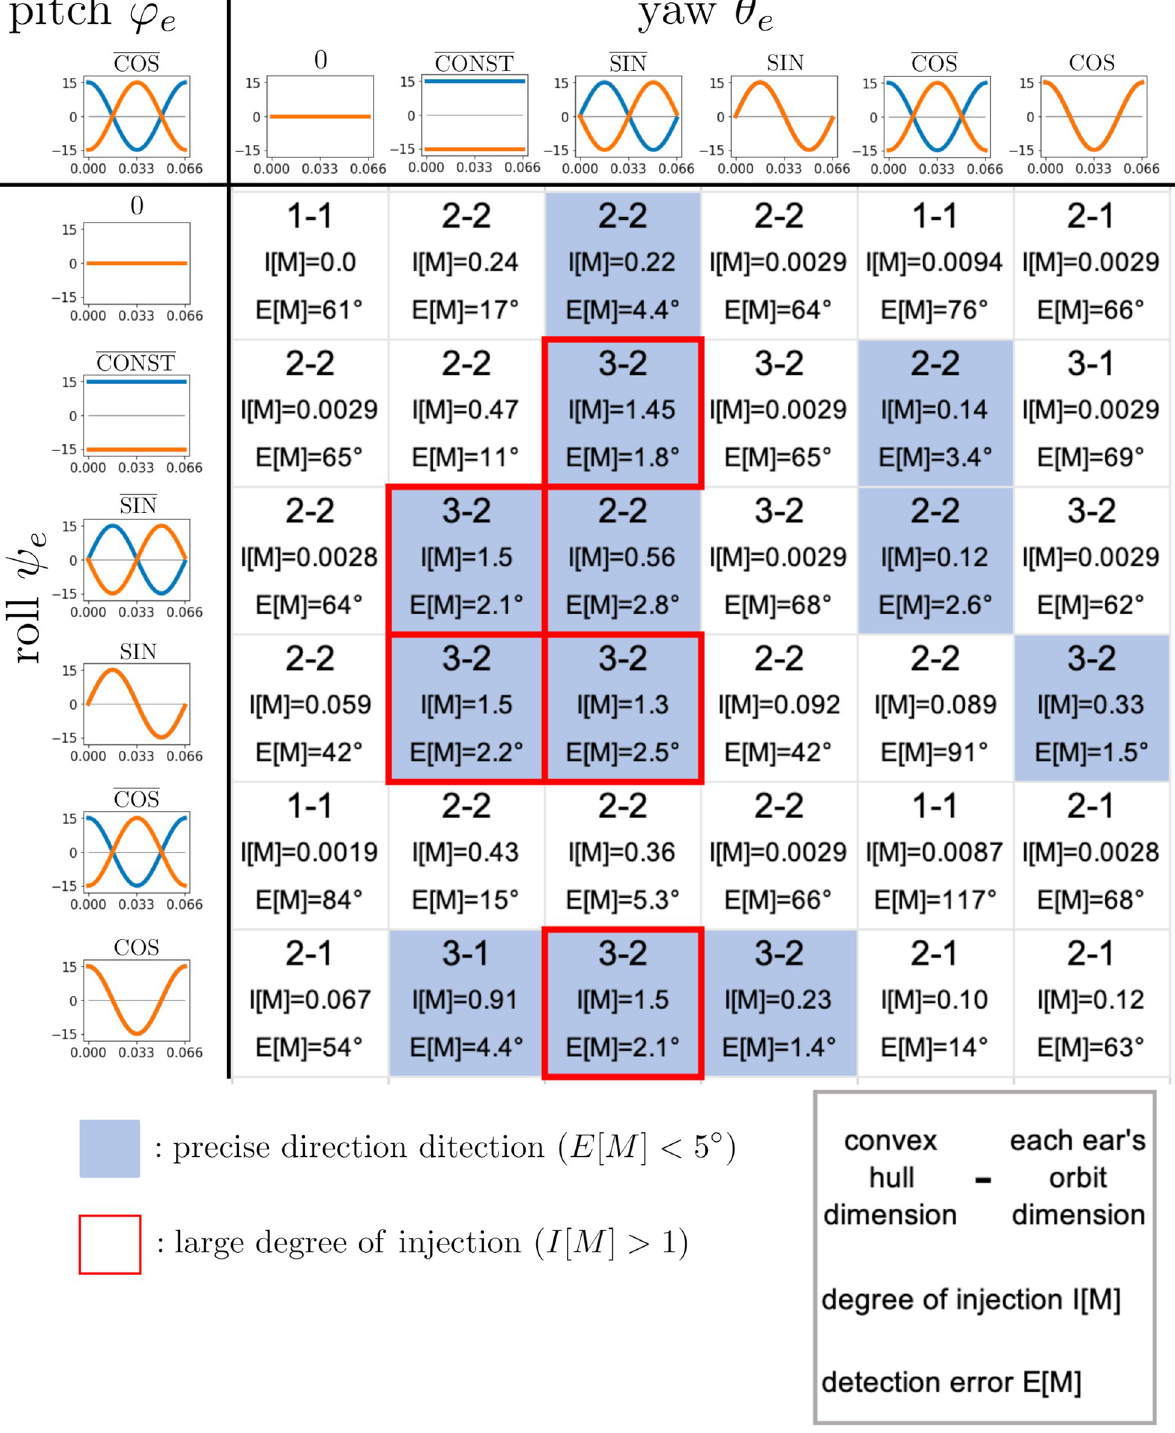
PLOS Computational Biology | https://doi.org/10.1371/journal.pcbi.1009784 October 7, 2022 14 /